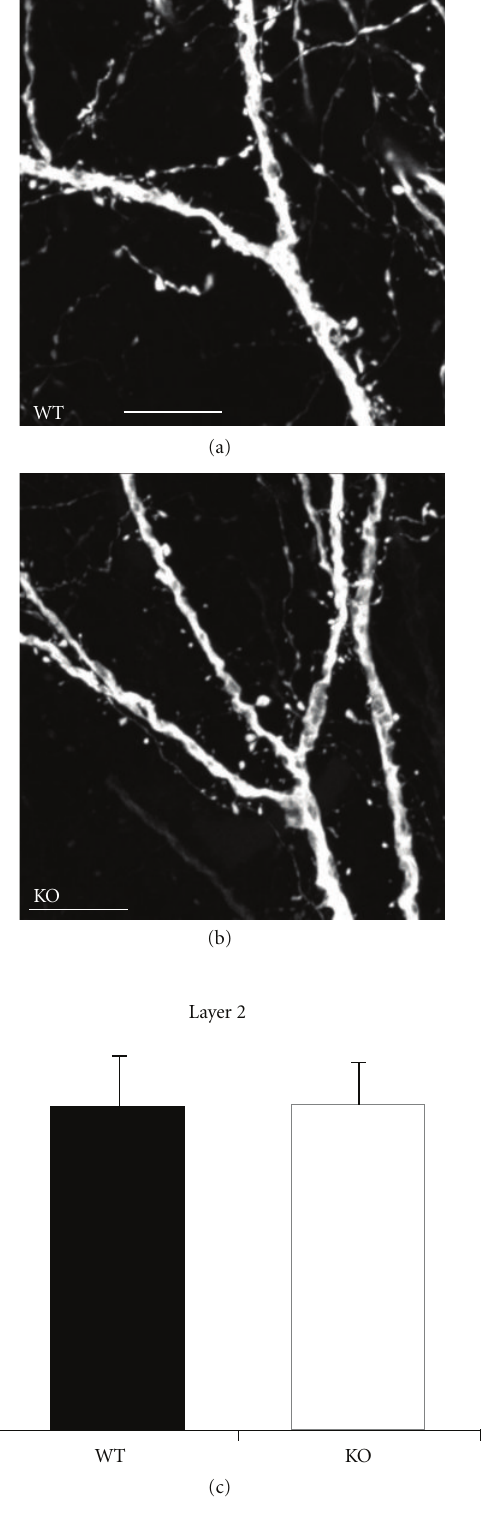
Figure 3: Comparison of spine density in wildtype and prestin knockout animals. Images of dendritic sections in layer 2/3 of A1 of WT (a) and KO (b) mice. (c) Layer 2/3 spine density did not di ff er significantly between genotypes ( P > . 05). Images of dendritic sections in layer 4 of A1 of WT (d) and KO (e) mice. (f) Layer 4 spine density did not di ff er significantly between genotypes ( P > . 05). Scale bars: 10 μ